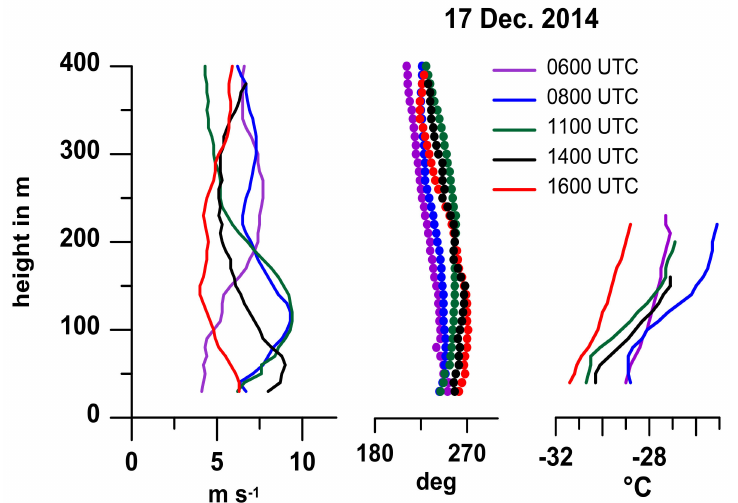
Figure 10. Vertical profiles from SODAR/RASS of the wind speed ( left ), wind direction ( middle ) and temperature ( right ) for 17 December